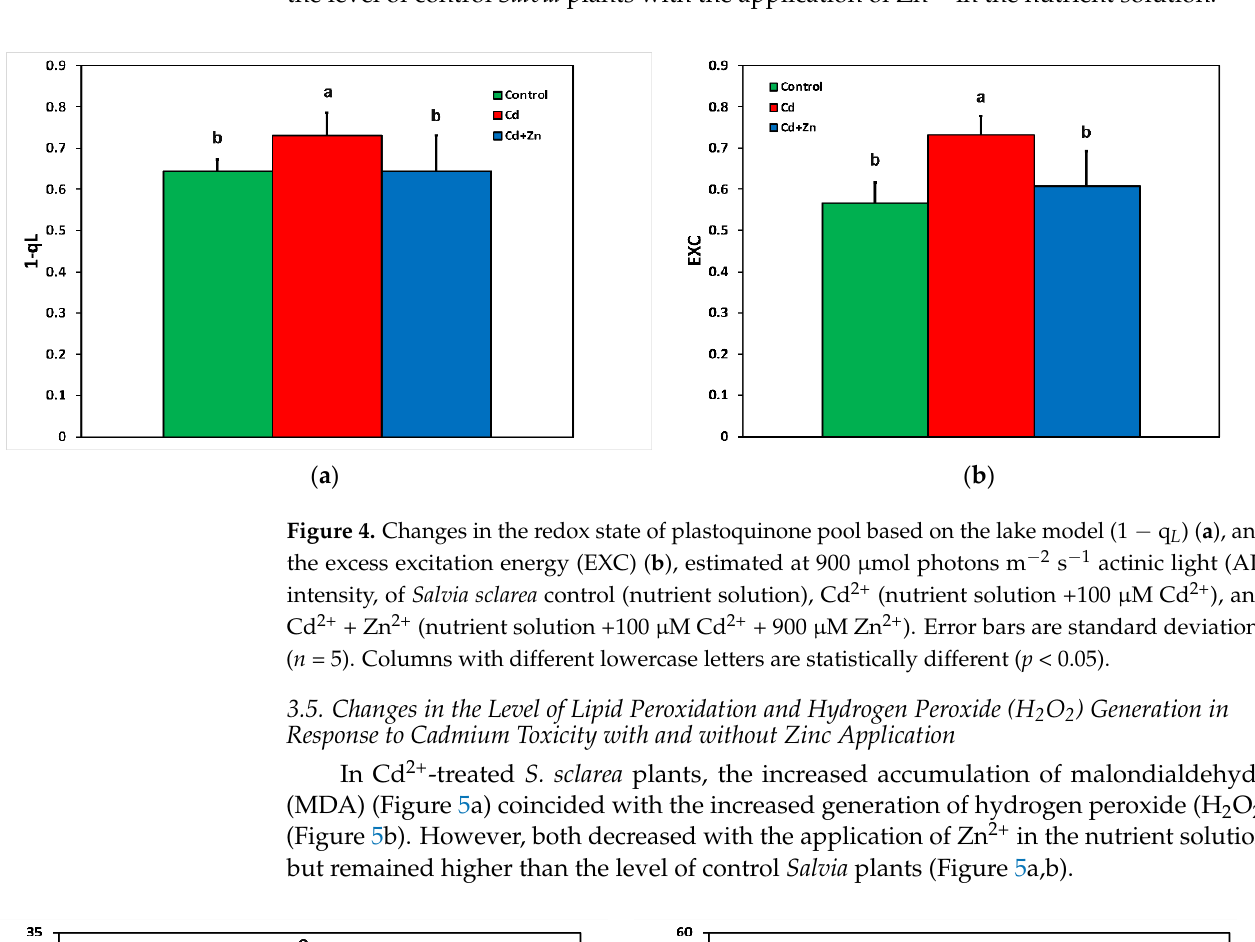
Figure 3. Changes in the maximum efficiency of photosystem II ( Fv / Fm ) ( a ), and the redox state of quinone A (Q A ), an estimate of the fraction of open PSII reaction centers estimated at 900 μ mol pho- tons m –2 s –1 actinic light (AL) intensity ( qp ) ( b ), of Salvia sclarea control (nutrient solution), Cd 2+ (nu- trient solution +100 μ M Cd 2+ ), and Cd 2+ + Zn 2+ (nutrient solution +100 μ M Cd 2+ + 900 μ M Zn 2+ ). Error bars are standard deviations ( n = 5). Columns with different lowercase letters are statistically differ- ent ( p < 0.05).